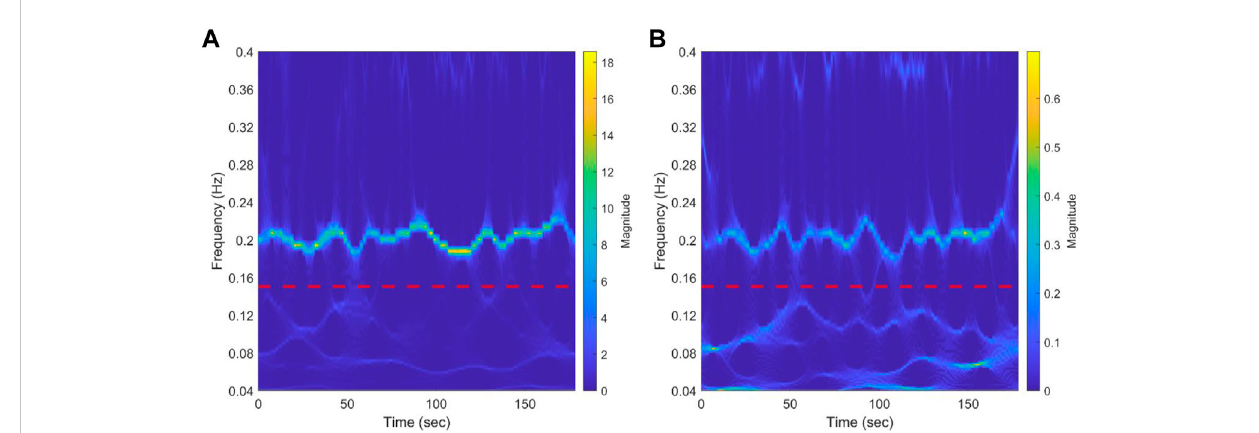
FIGURE 4 Results of synchrosqueezed transform of RR interval (A) and systolic blood pressure (B) during baseline from a representative normotensive pregnant woman. The red dottedline separates low-frequencybands (0.04-0.15 Hz) from thehigh-frequency band(0.15-0.4 Hz).A bridge representing respiration modulation in the HF band can be clearly seen. In the LF band, almost three bridges that cross each other can be identi fi ed.